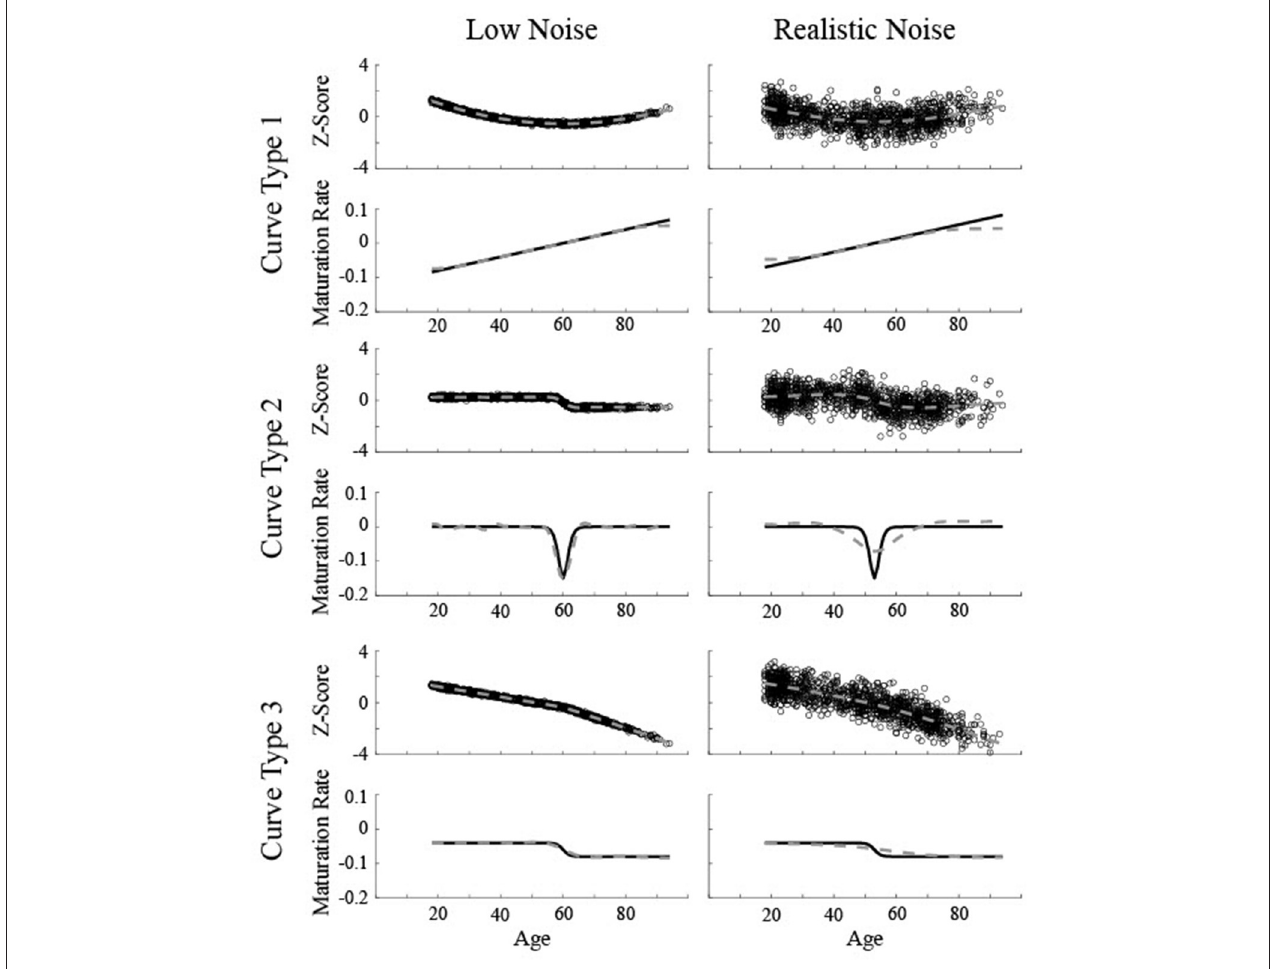
FIGURE 2 | Simulated data created based on three different curves for two different levels of noise (Low Noise, σ represent volume (z-score) and the bottom rows show the actual instantaneous slope (maturation rate: age for all three low noise curves is 60. The critical age for all three realistic noise curves is